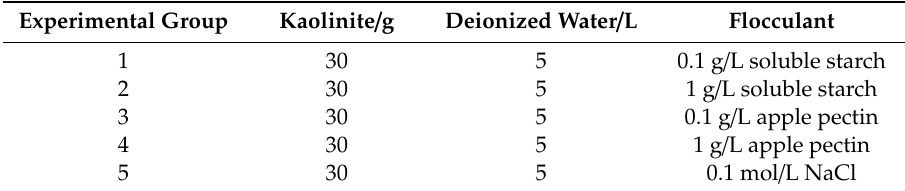
Table 1. Experiment groups for testing the sedimentation rate. Experimental Group